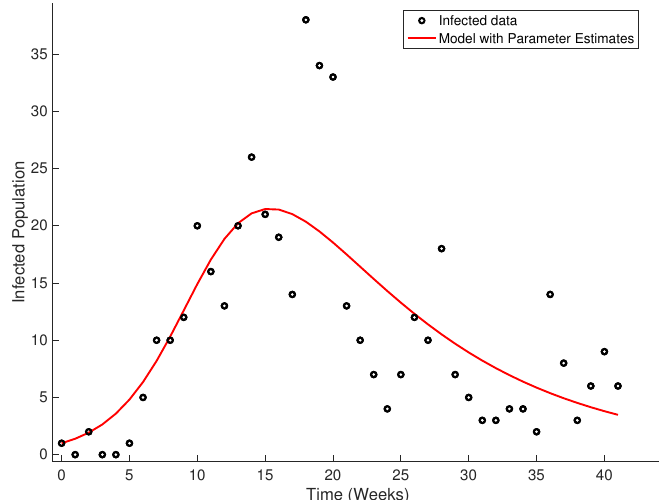
Figure 23. Fitted curve from real data of Olmué city, Chili.